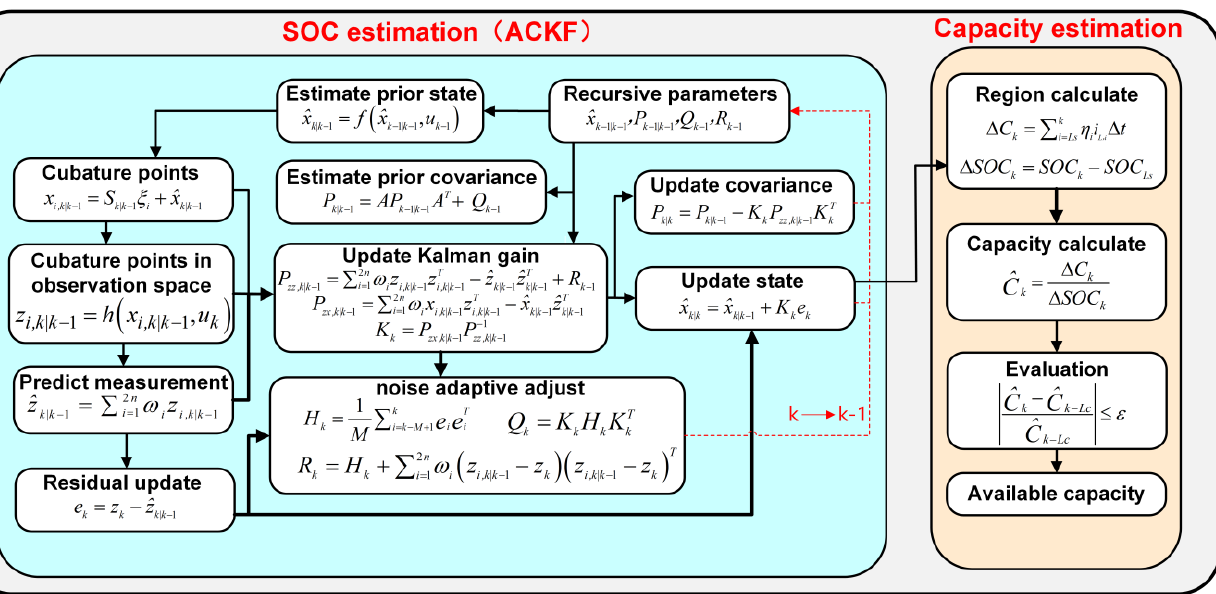
Figure 7. Flowchart of state of charge (SOC) and capacity estimation.